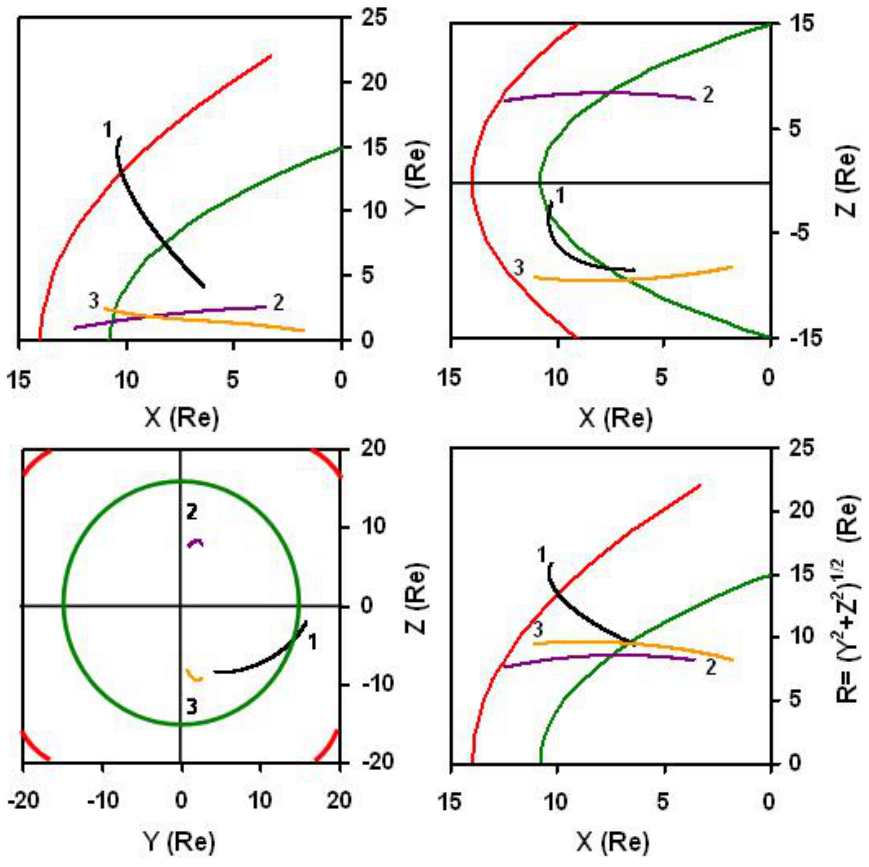
Fig. 3. Trajectory of the Cluster spacecraft in magnetosheath in (a) xy-, (b) xz-, (c) yz-, and (d) xR- planes for (1) 2 January 2002, (2) 11 March 2002, and (3) 4 February 2003. The magnetopause and bow shock was drawn for average solar wind